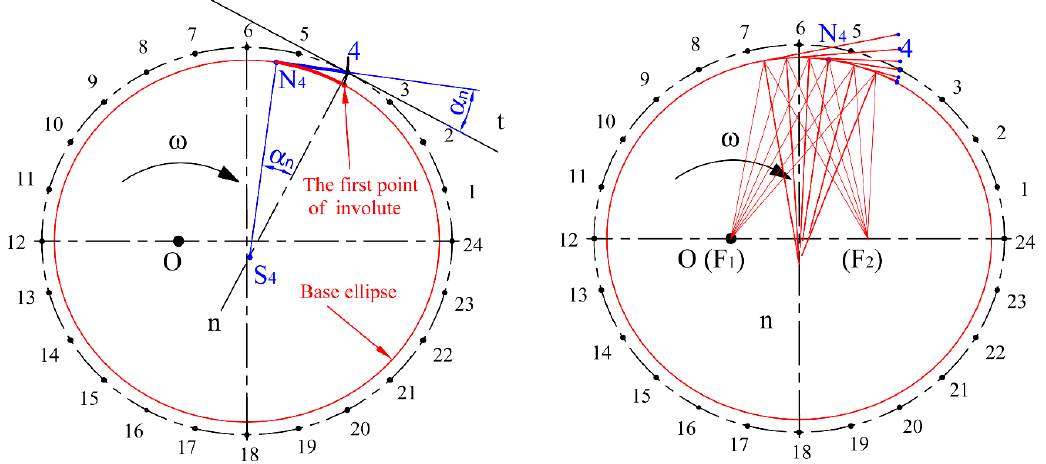
Figure 11. Example of involute construction from base ellipse for the tooth with number 4.